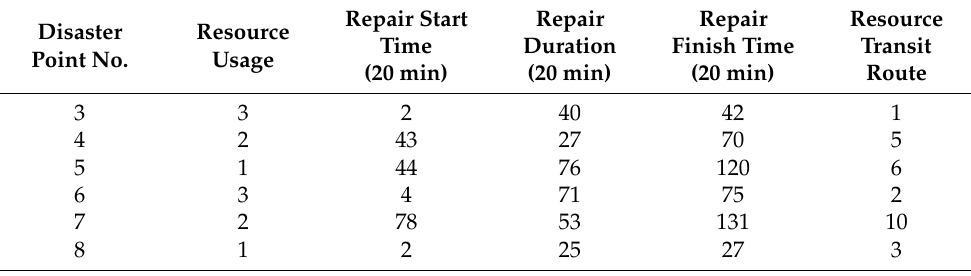
Table 8. Scheduling results of the initial stage of the disaster (Case 2).